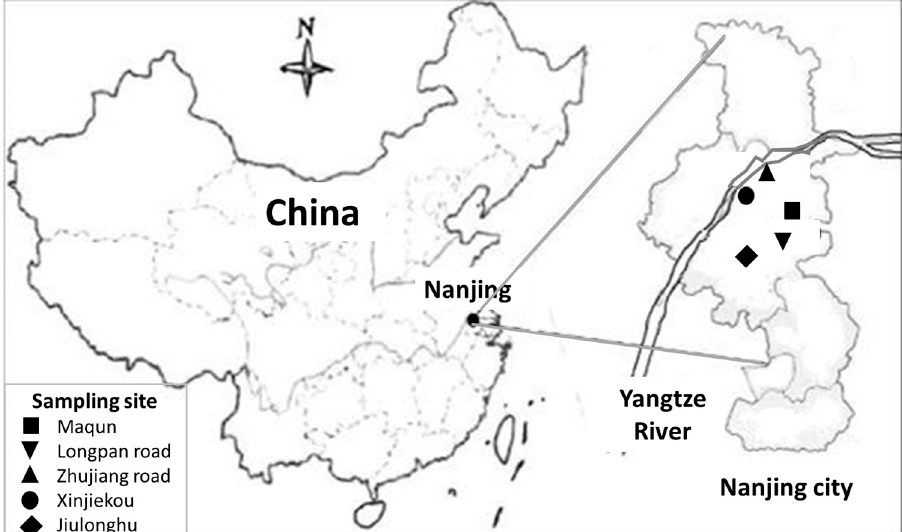
Figure 1. Sampling sites.